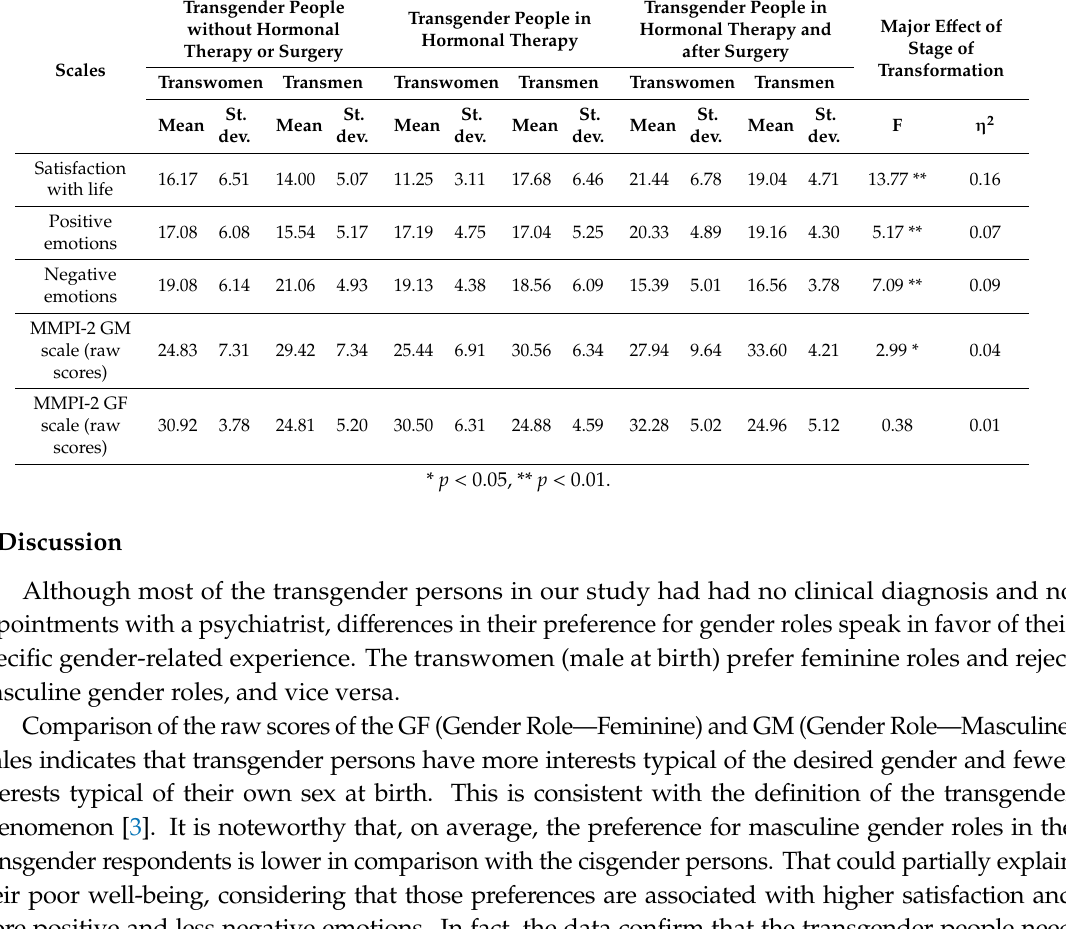
Table 2. Well-being and preference for gender roles in the transgender participants at di ff erent stages of transformation. Transgender People Transgender People in Transgender People in Major E ff ect of Hormonal Therapy and without Hormonal Hormonal Therapy Stage of after Surgery Therapy or Surgery Scales Transformation Transwomen Transmen Transwomen Transmen Transwomen Transmen St. St. St. St. St. St. F η Mean Mean Mean Mean Mean Mean dev. dev. dev. dev. dev. dev.